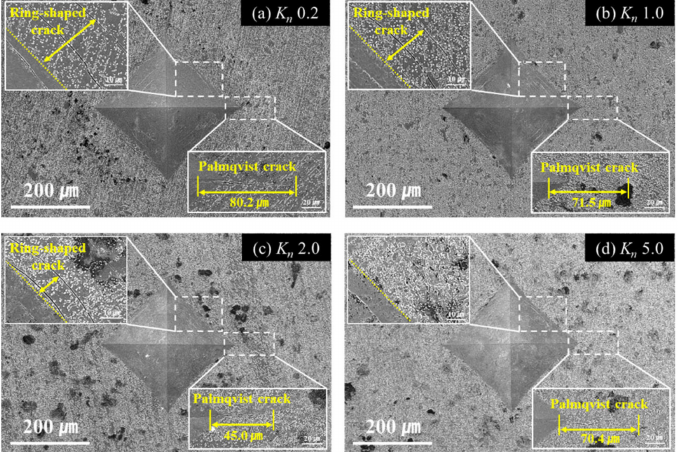
Figure 7. SEM images of the nitrided surface showing the ring-shaped cracks and Palmqvist cracks due to the Vickers indentation under various nitriding potentials at K n = ( a ) 0.2, ( b ) 1.0, ( c ) 2.0, and ( d ) 5.0 atm − 1/2